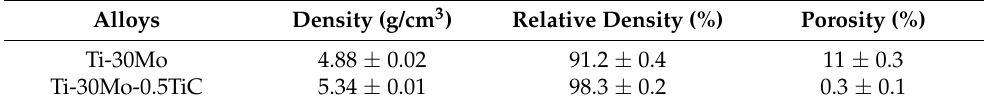
Table 1. Relative density and porosity of Ti-30Mo-nTiC alloys.